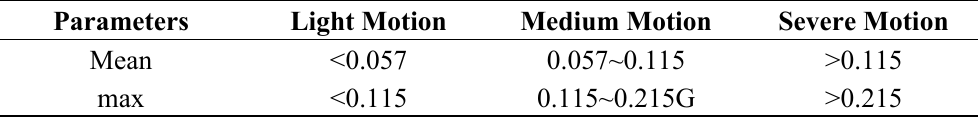
Table 2. References scale of three motion levels (unit =